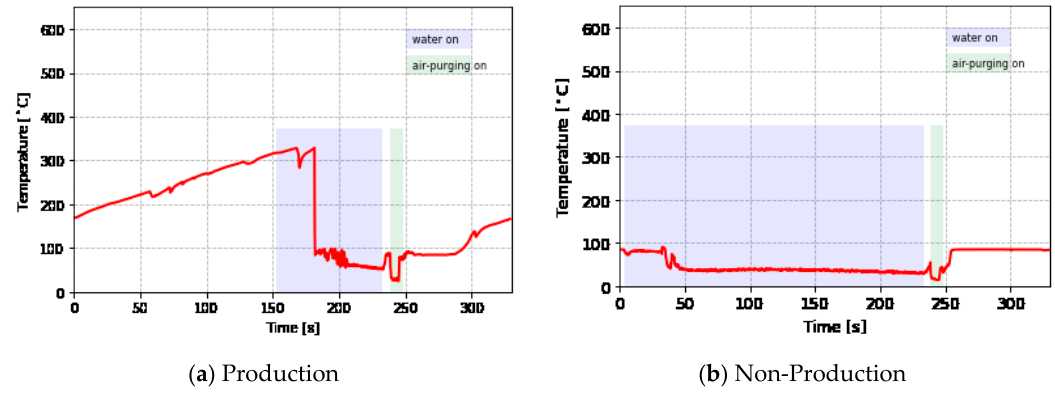
Figure 13. Temperature measured within the cooling channel T3 by TC TD21 in Die-A.